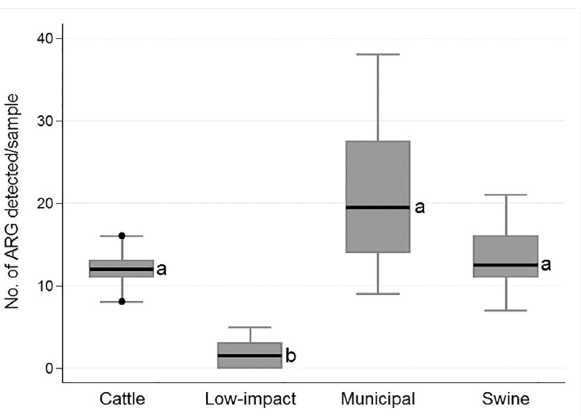
Fig 1. Box plot showing median distribution of antimicrobial resistance genes detected per pooled sample among cattle (n = 12), low impact environment (n = 8), municipal (n = 12) and swine (n = 12) samples. The bold horizontal lines represent the median. The whiskers represent the upper and lower adjacent values. Superscripts have been assigned to the median. Different superscripts indicate statistically significant (P = 0.0001) differences between pairs of sample